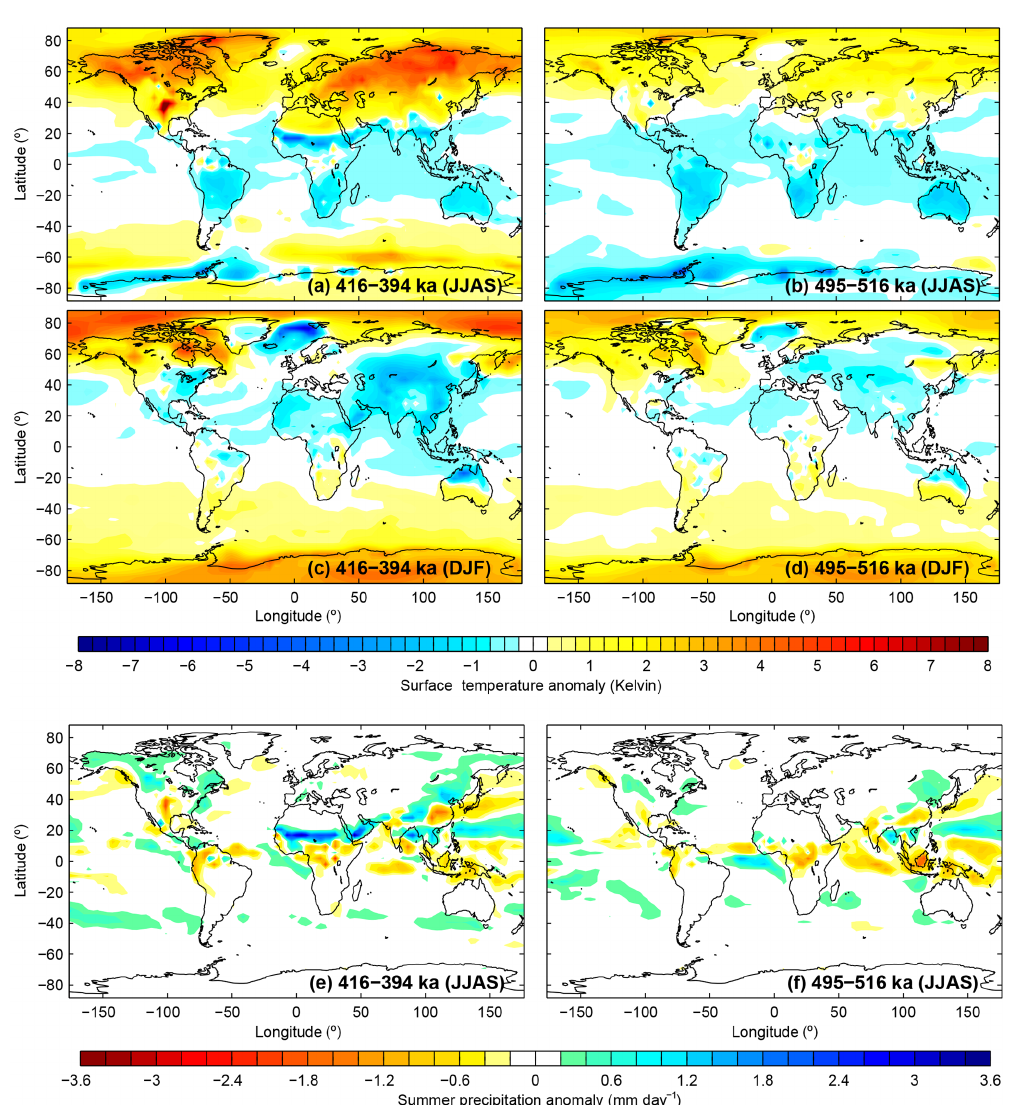
Figure 8. Differences in seasonal surface temperature (a–d) and boreal summer precipitation (e–f) for 416–394ka (left) and 495–516ka